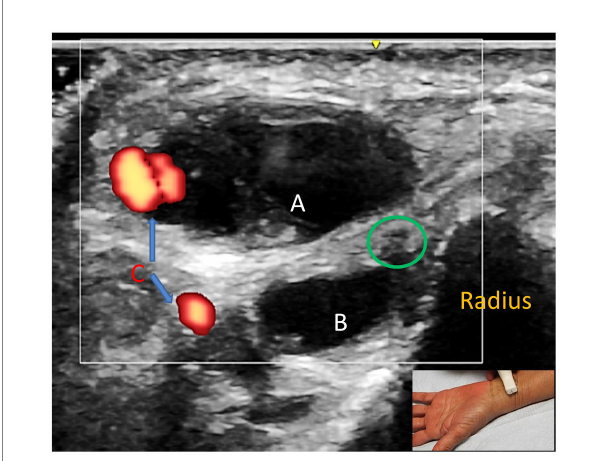
FIGURE 2 Case 33: Short axis view proximal to the wrist showing bilobed cyst (A,B) and the superficial radial nerve (green circle). Color Doppler shows blood vessels (orange) close to the cyst (C)